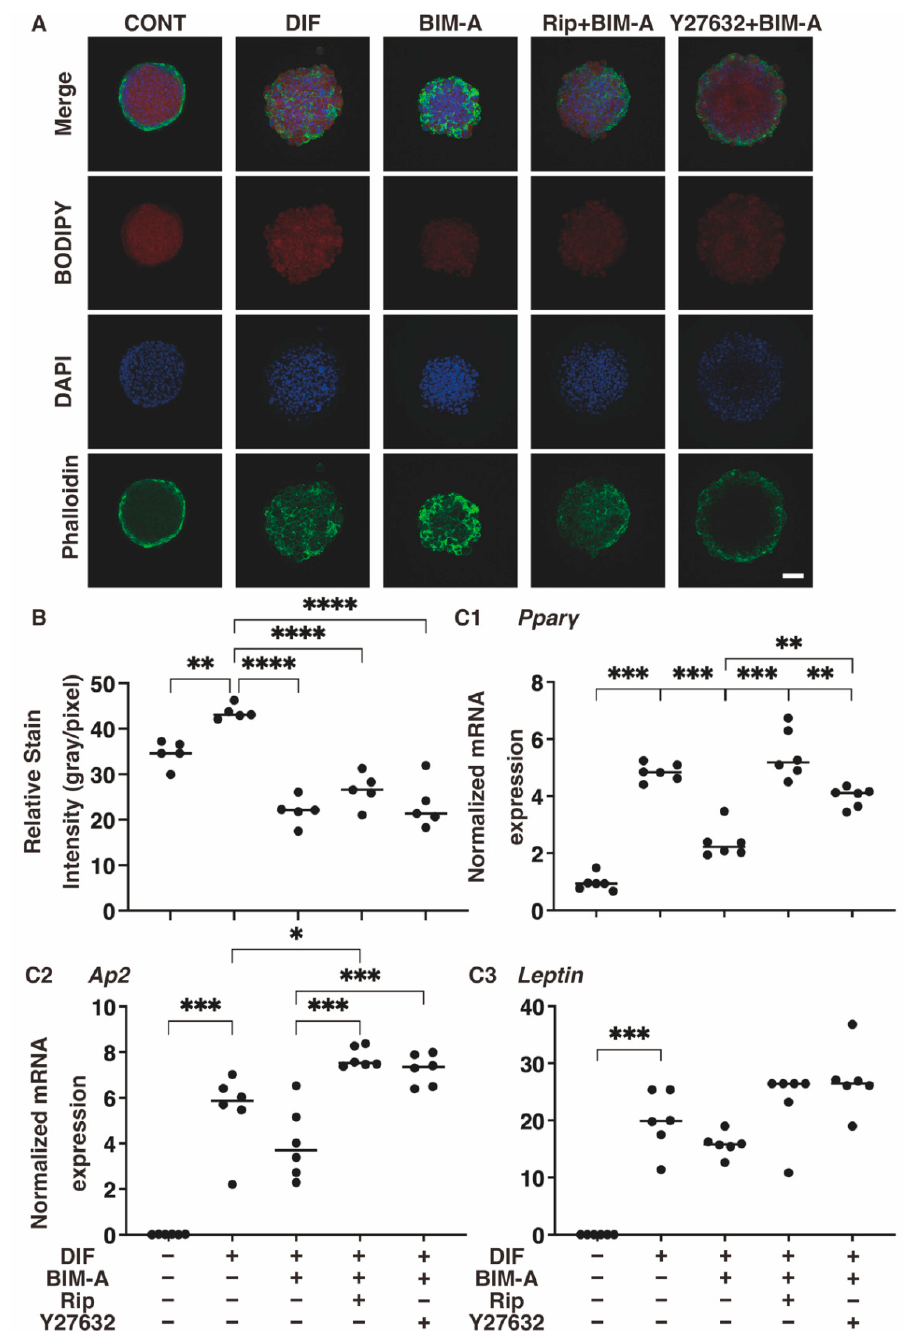
Figure 7. Additional effects of ROCK-i on BIM-A during the adipogenesis of 3T3-L1 3D spheroids. The 3D spheroids of 3T3-L1 cells were prepared under several conditions: preadipocytes of 3T3-L1 cells (CONT) or their adipogenic differentiation (DIF) with or without the combination of 100 nM BIM-A (BIM-A) and ROCK-i (10 μ M Ripasudil (Rip) or 10 μ M Y27632). These were immunostained by DAPI (blue), phalloidin (green) and BODIPY (red). Merge and BODIPY images are shown in panel ( A ) (scale bar: 100 μ m) and their staining intensities (gray/pixel) were plotted (panel ( B )). The mRNA expressions of adipogenesis-related genes, including Ppar γ and Leptin , under the above conditions were plotted in panel ( C1 – C3 ). All experiments were performed in duplicate using fresh preparations, each consisting of 16 spheroids. Data are presented as the arithmetic means ± the standard error of the mean (SEM). * p < 0.05, ** p < 0.01, *** p < 0.005, **** p < 0.001 (ANOVA followed by a Tukey’s multiple comparison